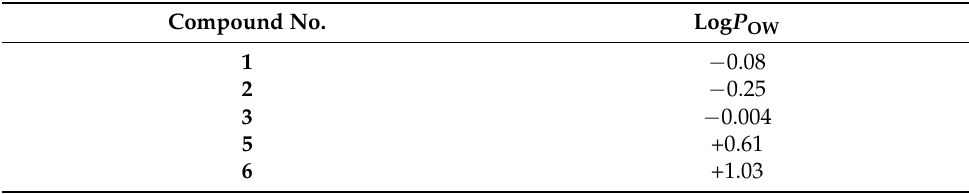
Table 1. Log P OW value calculated from the octanol/water partition coefficient of 1, 2, 3, 5, 6. Compound No.